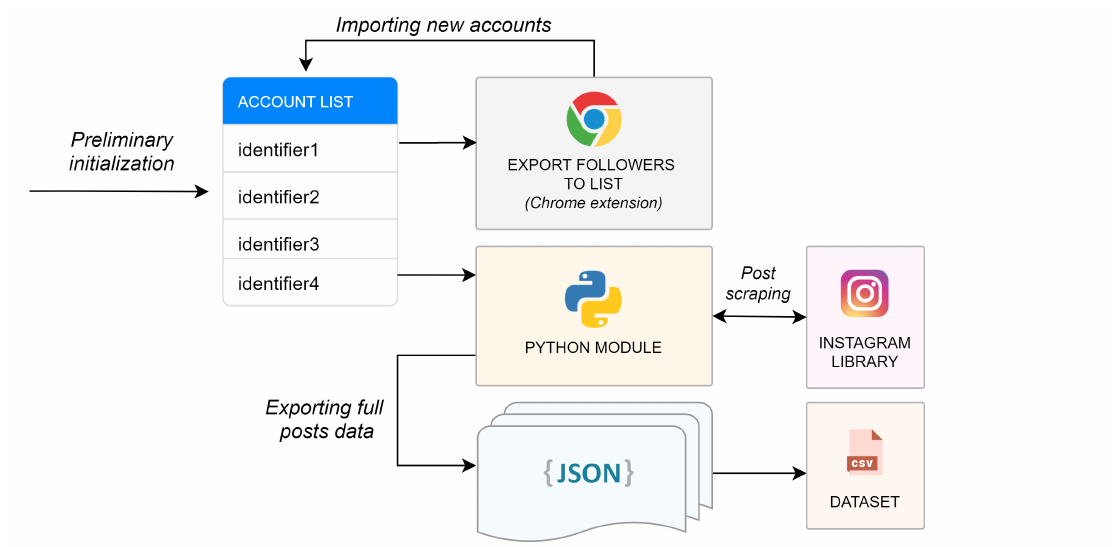
Figure 1. High-level schema of the data collection